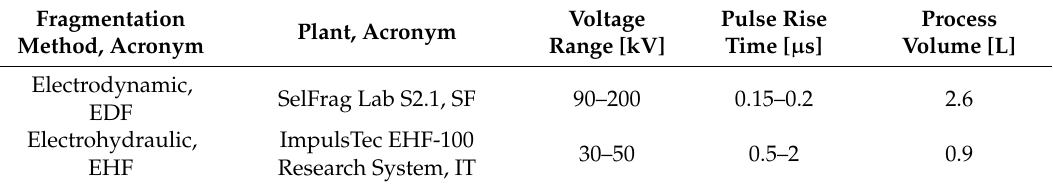
Table 1. Pulsed power generators used for benchmark